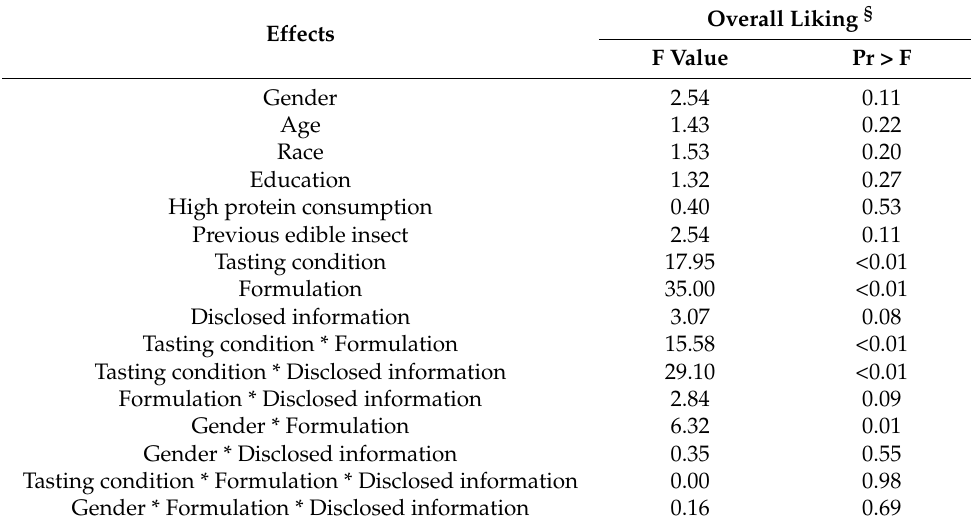
Table 2. ANOVA † table for the overall sensory acceptability of CB treatments ‡